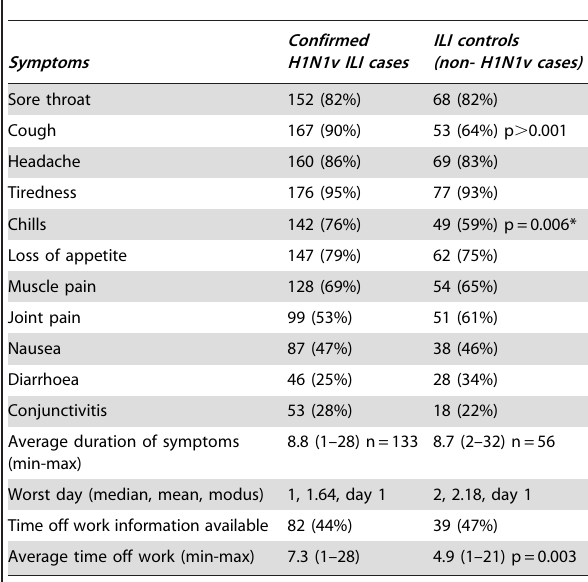
Table 2. Symptoms reported by